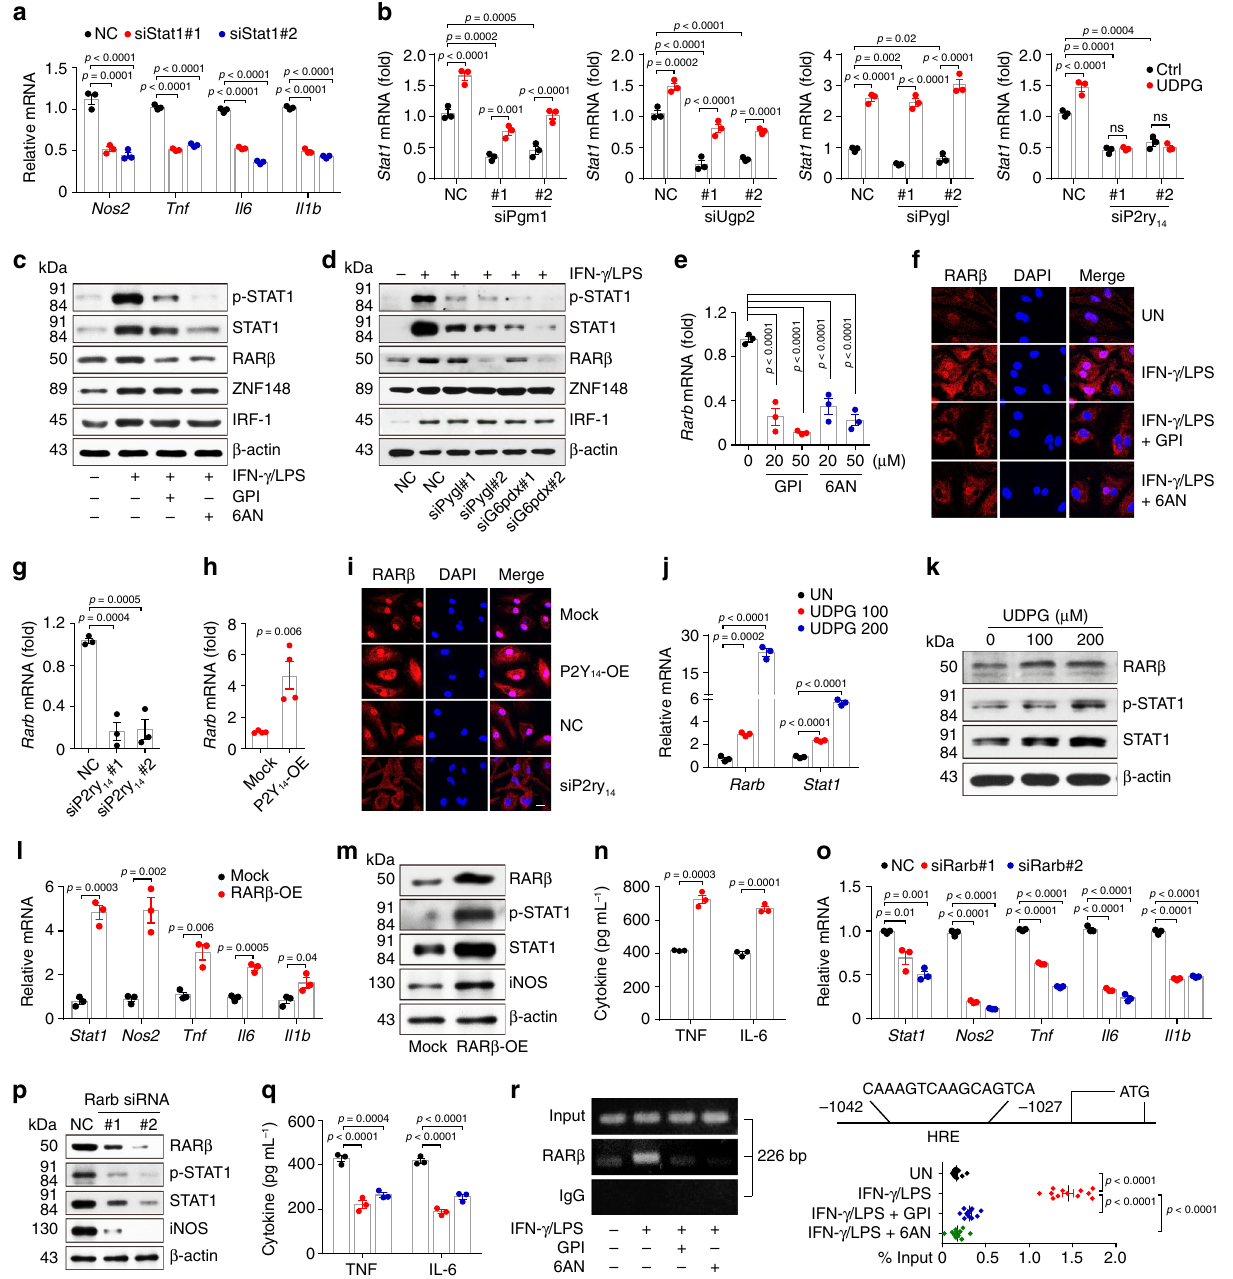
Fig. 5 UDPG-P2Y 14 pathway regulates STAT1 expression. a Stat1 siRNA transfected BMDMs were stimulated with IFN- γ /LPS for 24 h, Nos2 , Tnf , Il6, and Il1b expression was determined by real-time PCR. b Pgm1 , Ugp2 , Pygl or P2ry 14 siRNA transfected BMDMs were stimulated with IFN- γ /LPS ± UDPG for 24 h, Stat1 expression was determined by real-time PCR. c – f BMDMs were pretreated with inhibitor (GPI or 6AN) for 30 min or pre-transfected with siRNA ( Pygl or G6pdx ) for 24 h prior to stimulation with IFN- γ /LPS for 24 or 36 h, STAT1, ZNF-148, IRF-1, and RAR β expression was determined by western blot ( c , d